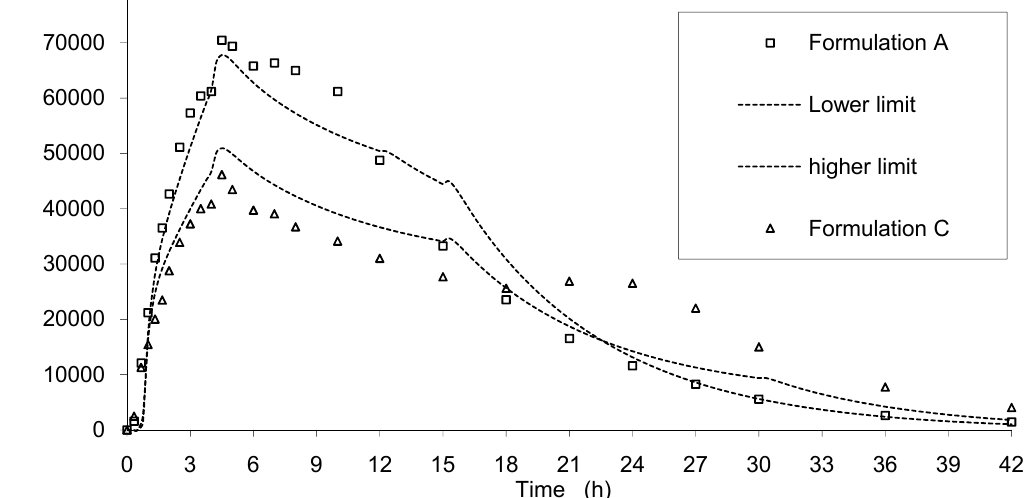
Figure 12. In vivo formulations A and C and the lower and upper limits based on calculated dissolution limits of formulation B to ensure